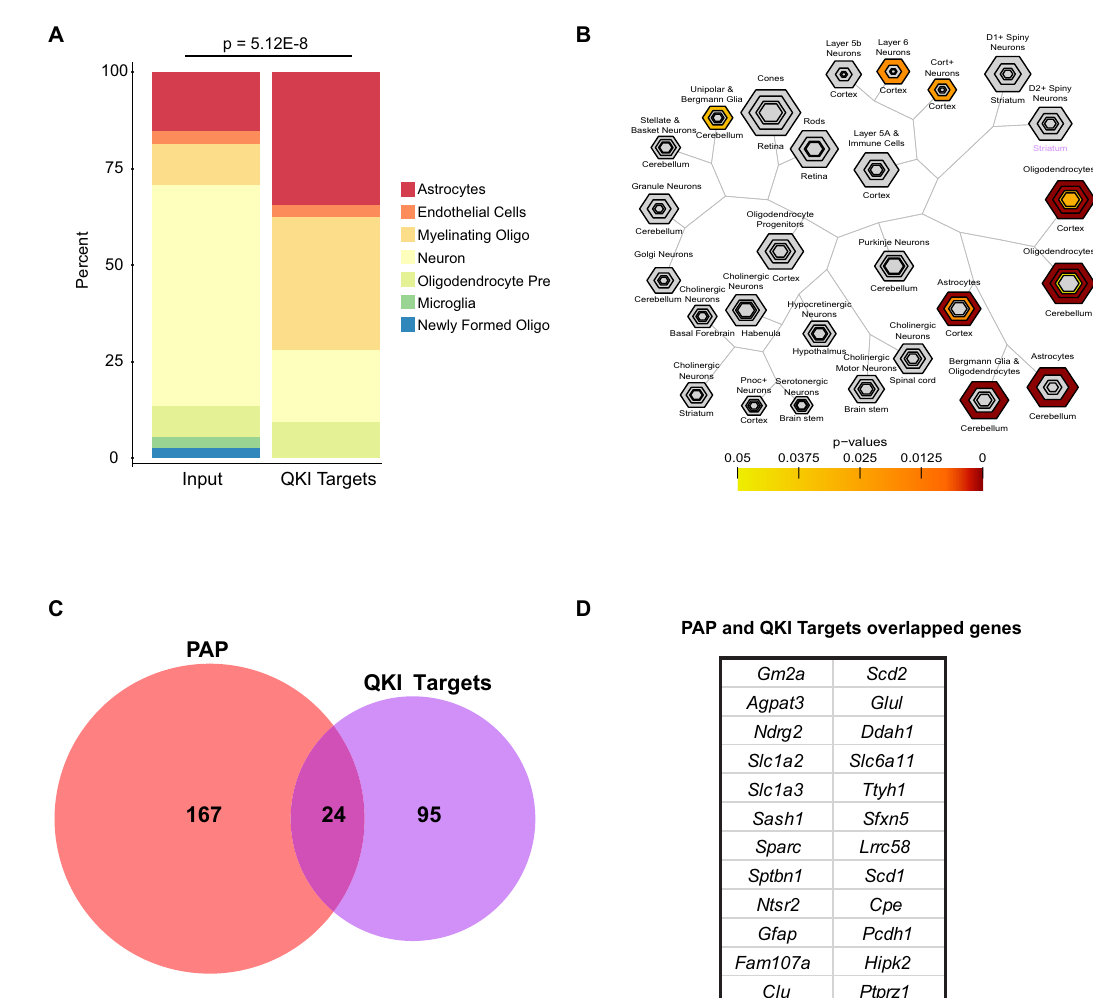
Fig. 3 QKI-6 targets membrane protein transcripts in astrocytes. A QKI-6 targets are signi fi cantly enriched in transcripts from astrocytes compared to Input transcripts. P value represents two-sided Fisher ’ s exact test. Cell-type speci fi c data is FPKM from ref. 21 (brainrnaseq.org). B Unbiased CSEA analysis 36 shows QKI-6 targets are most strongly enriched in transcripts enriched in astrocytes and oligodendrocytes. Hexagons represent list of genes enriched in each cell type going from pSI threshold to include larger but less stringent gene lists (in this cell type and a few others) to thresholds for the most stringent subsets (smallest, central hexagons). Fisher exact testing is used to establish p value for each CLIP target and each gene list at each threshold and corrected by Benjamini – Hochberg for the number of cell types (color bar). Results consistent across more than one threshold hexagon per cell type are viewed with greater con fi dence. C Venn diagram of overlapping genes from PAP-TRAP 29 and QK CLIP targets. D List of overlapping genes in C